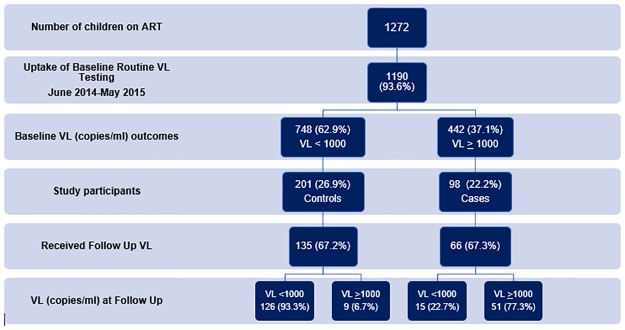
Kenya National HIV viral load monitoring algorithm 2013.